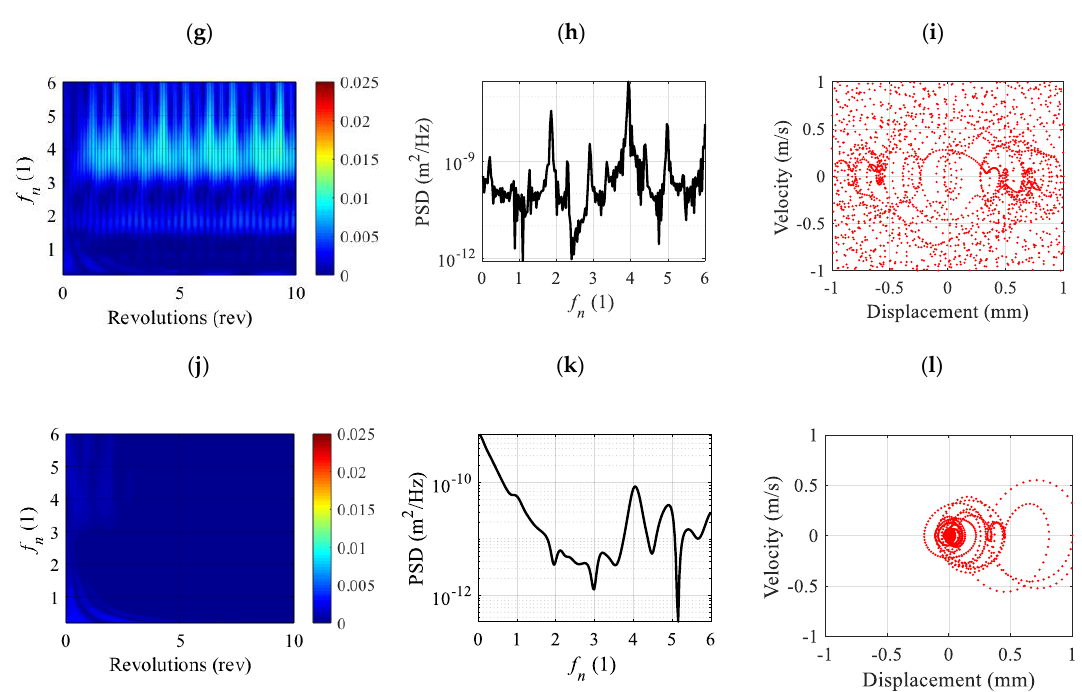
Figure 8. Analysis of cutting conditions D, E, F and G. CWT scalogram:s ( a , d , g , j ); PSD: ( b , e , h , k ) and PM: ( c , f , i , l ) corresponds to the cutting conditions D, E, F and G respectively.